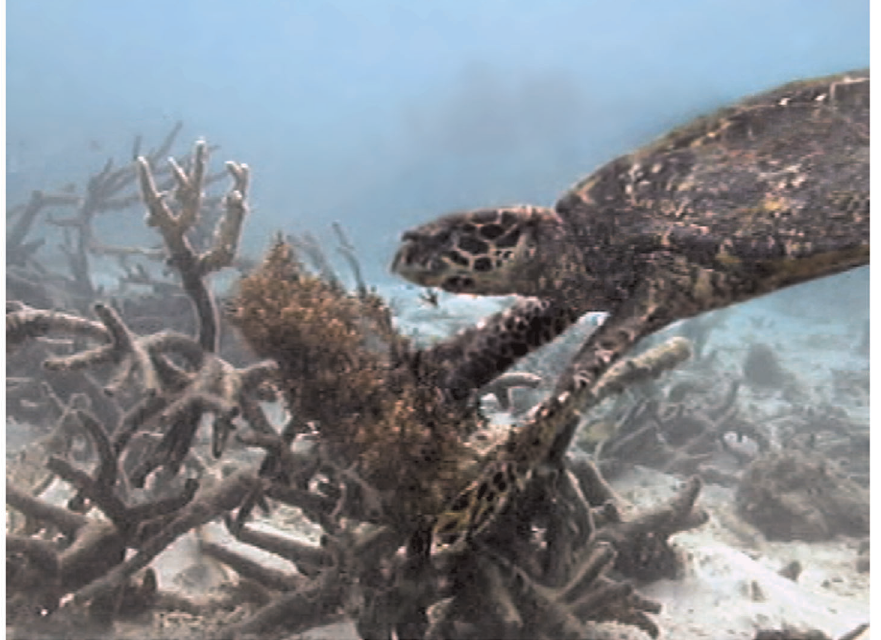
Figure 3. A hawksbill turtle ( Eretmochelysimbricata ) feeding on a transplanted thallus of the brown macroalga Sargassumswartzii .